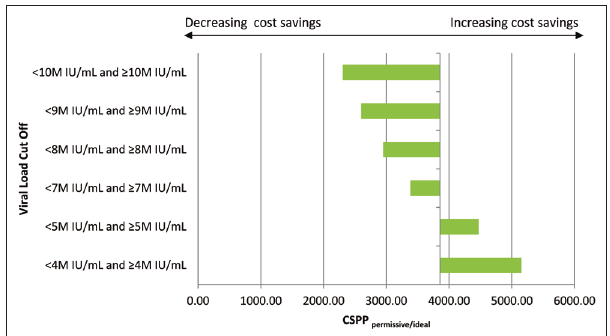
Figure 1) Cost savings per patient (CSPP) permissive/ideal with different hepatitis C virus viral load